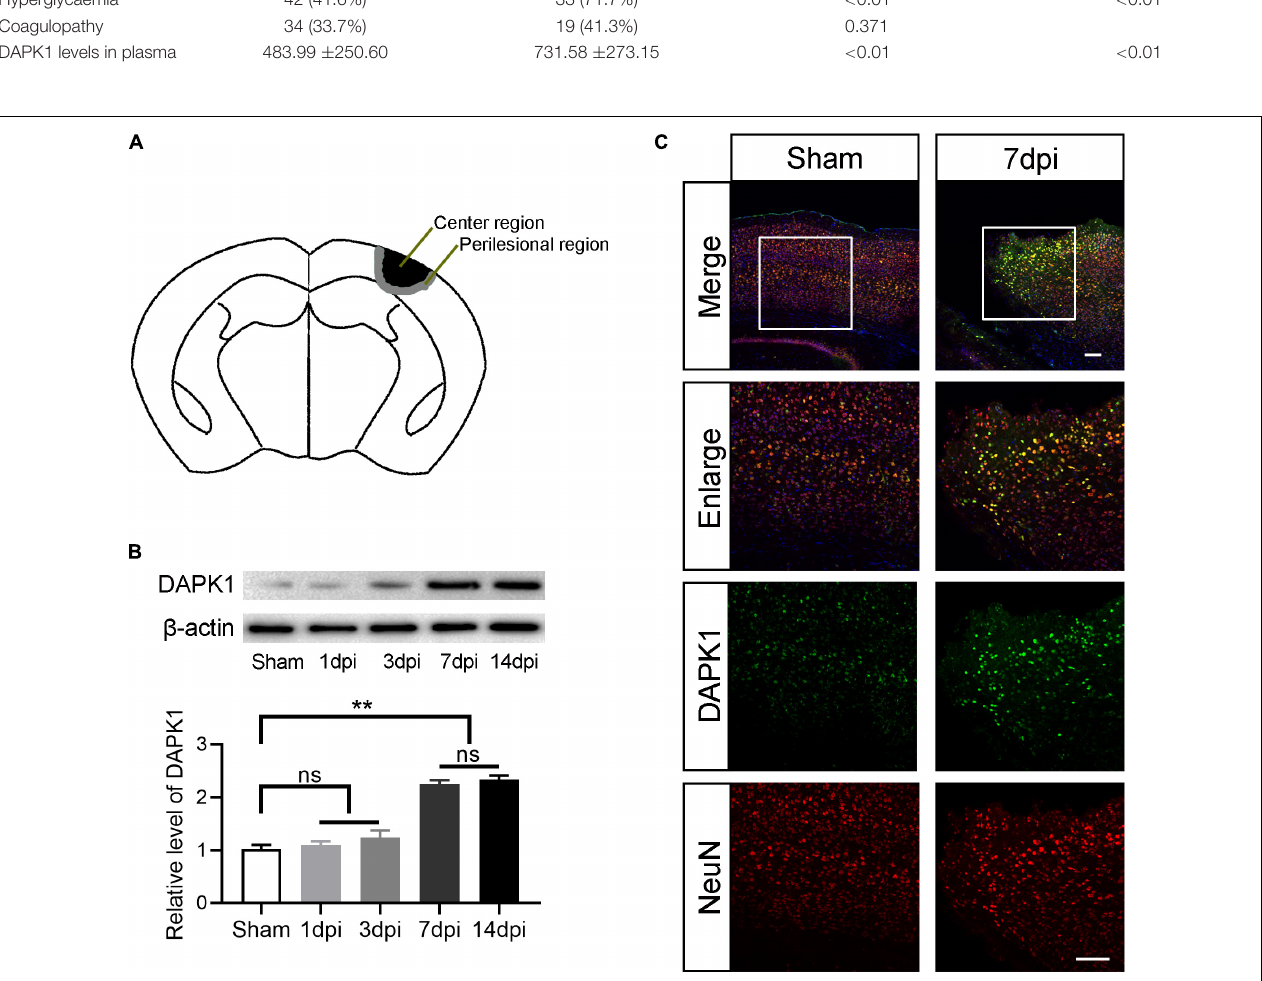
FIGURE 1 | DAPK1 is increase after TBI and mainly expressed in neurons. (A) Perilesional of the TBI was indicated in black and center of the TBI was represented in gray. (B) Western blotting analysis of the expression level of DAPK1 in the perilesional cortex at different time points after TBI. (C) Representative immunofluorescence images in the perilesional cortex at day 7 after TBI. Scale bar, 100 µ m. n = 6 for each group; ** p < 0.01; ns, no significance; Values are presented as the mean ± SEM.